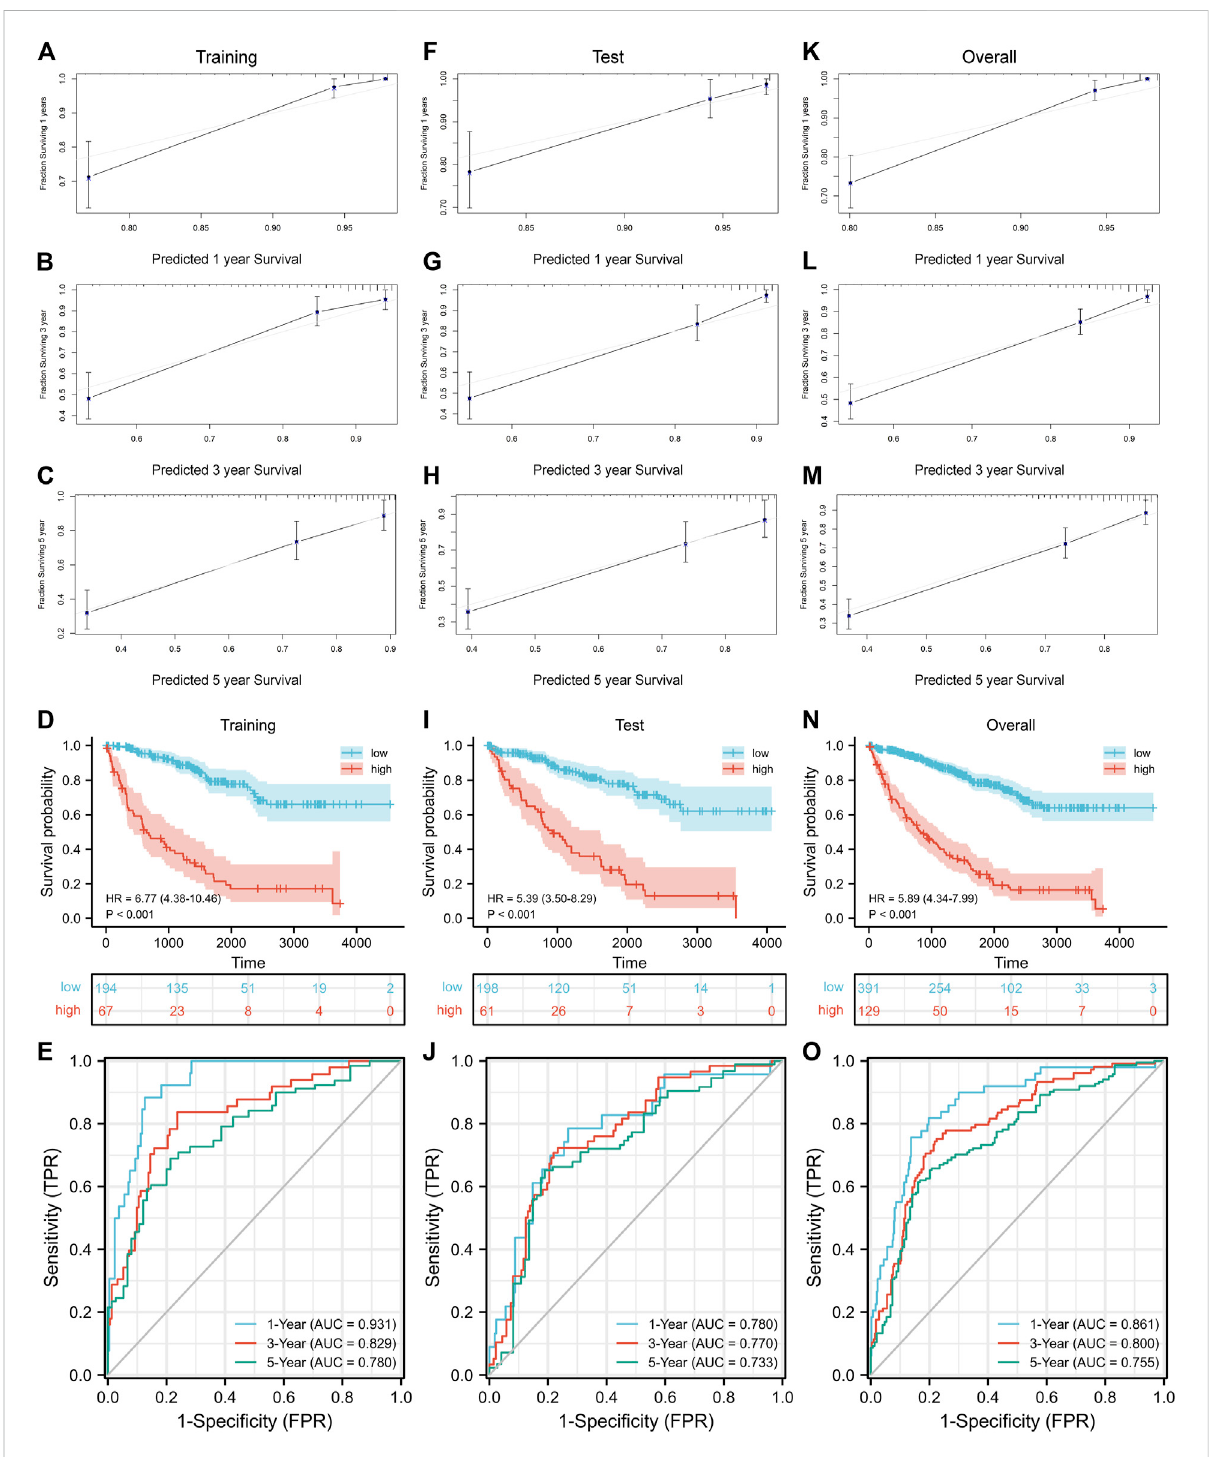
FIGURE 9 Evaluation of the nomogram. Con fi rmation of the nomogram coincidence at 1, 3, and 5 years with calibration curves in the training cohort (A – C) , test cohort (F – H) , and overall cohort (K – M) . Evaluation and veri fi cation of the prognostic value with survival analysis and ROC curves in the training cohort (D,E) , test cohort (I,J) , and overall cohort (N,O)